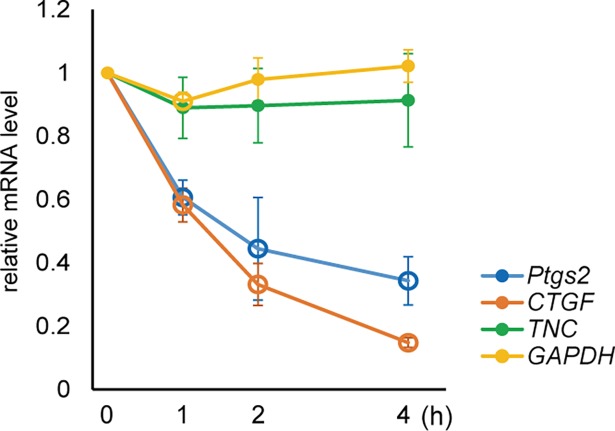
Sound-triggered gene response in the presence of RNA polymerase II inhibitor.ST2 cells were pre-treated with 5 μM α-amanitin for 1 hour and subjected to 440 Hz, 94.0 dB sine-wave sound for 0, 1, 2, and 4 hours. Open circles indicate statistically significant changes of each gene at each time point compared with 0 hour (P < 0.01). (Error bars represent standard deviation, n > 5.).